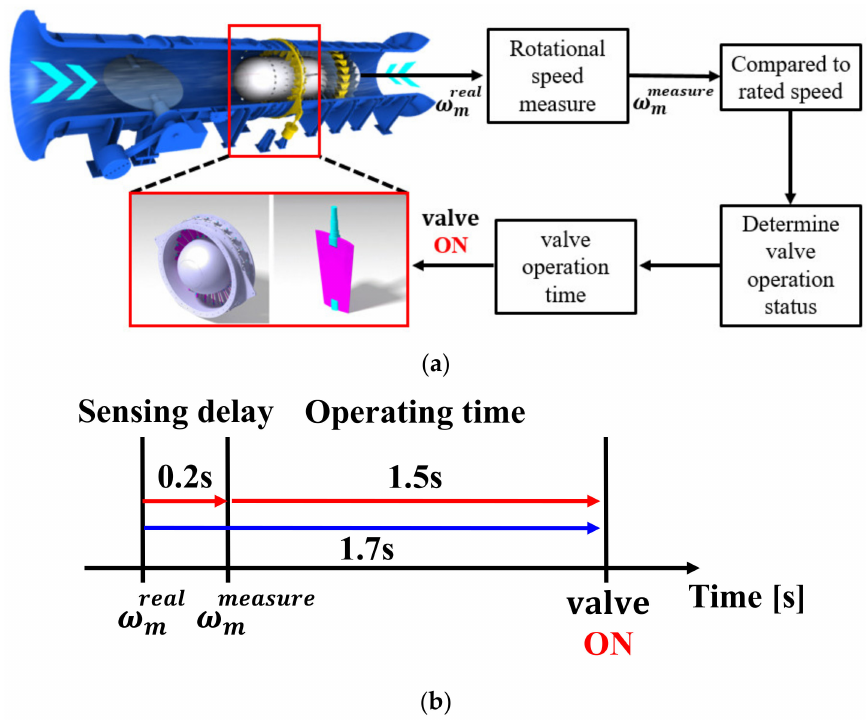
Figure 2. ( a ) Valve operation mechanism and ( b ) operating time delay for conventional rated power control.